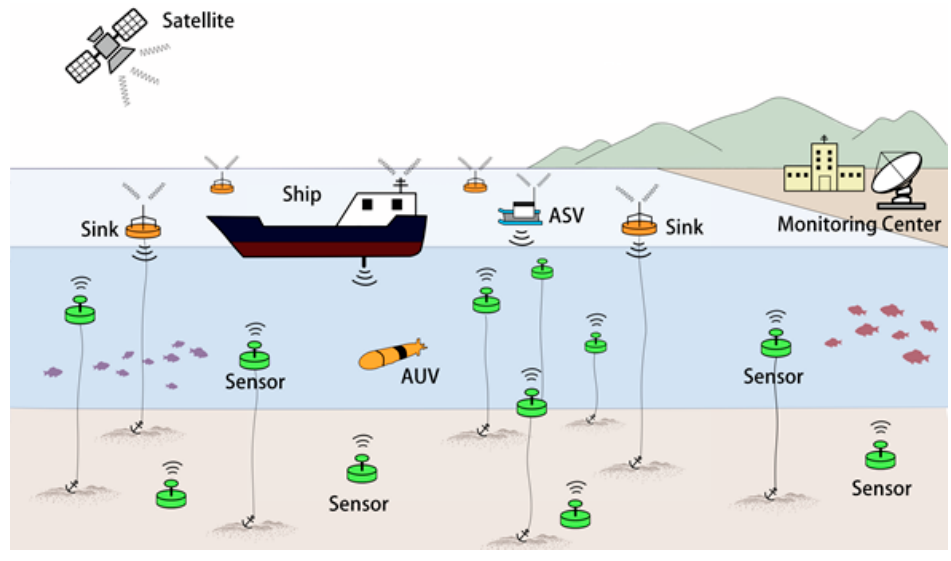
Figure 1. Network architecture of